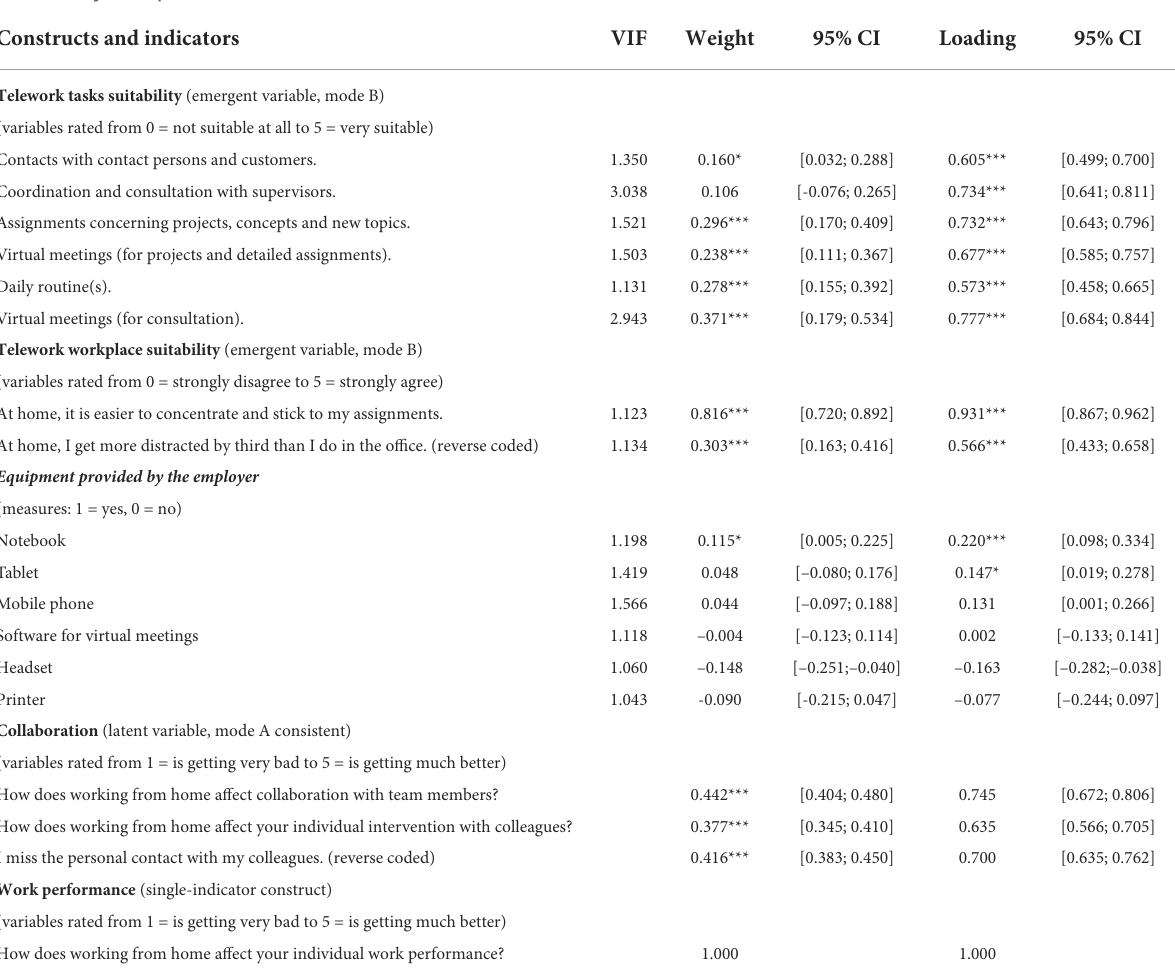
TABLE 2 Key concepts and their indicators.